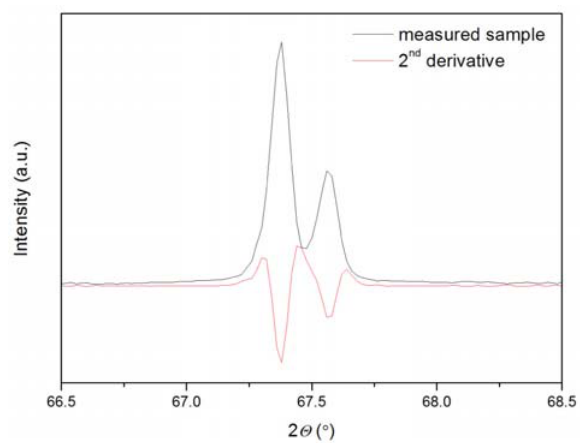
Figure 9. The original LaB